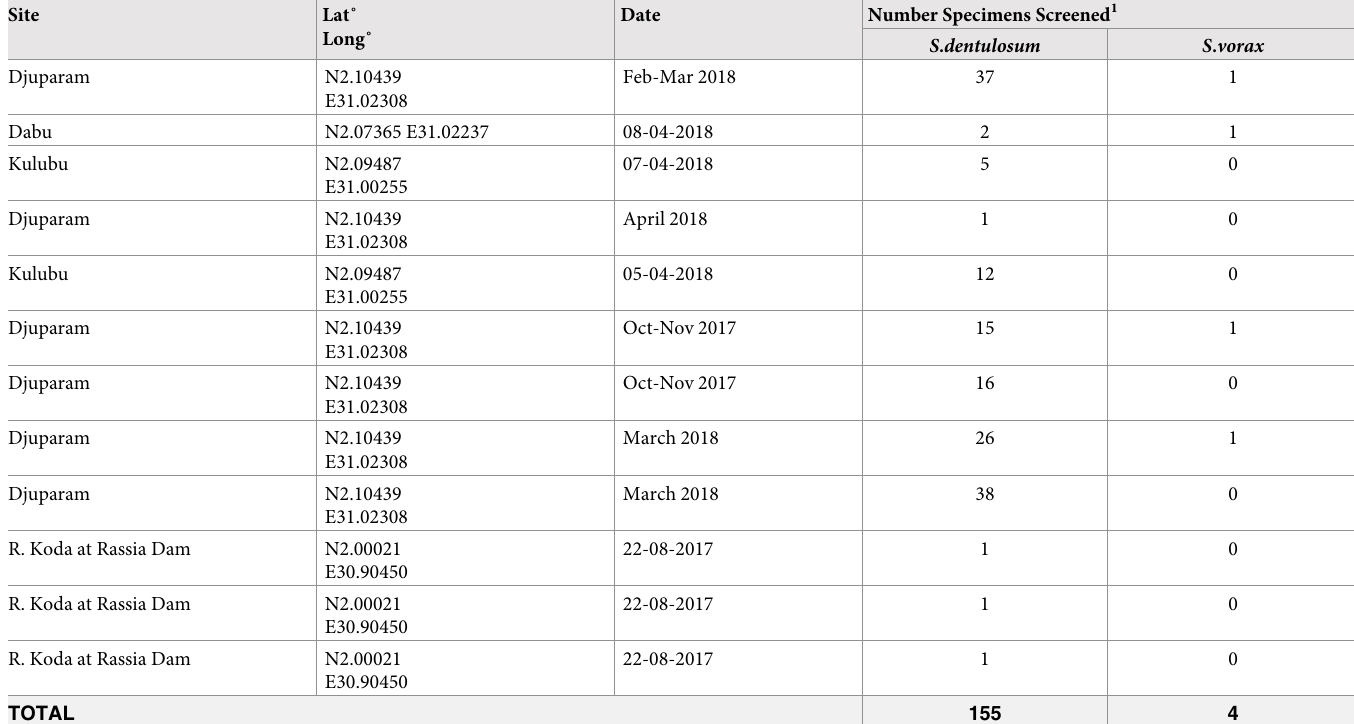
Table 1. Simulium samples screened for Onchocerca DNA in head and body.